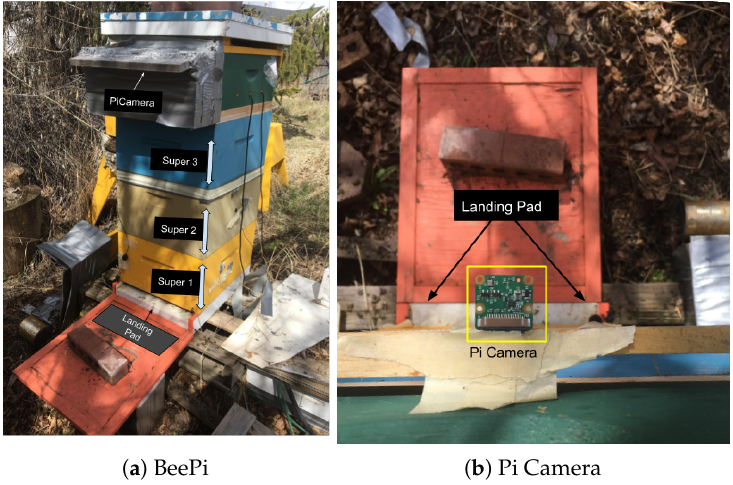
Figure 1. BeePi monitor ( a ) on top of Langstroth beehive of 3 supers; BeePi’s hardware components are in top green super; pi camera ( b ) is looking down on landing pad and is protected against elements by wooden box; hardware details and assembly videos are available at